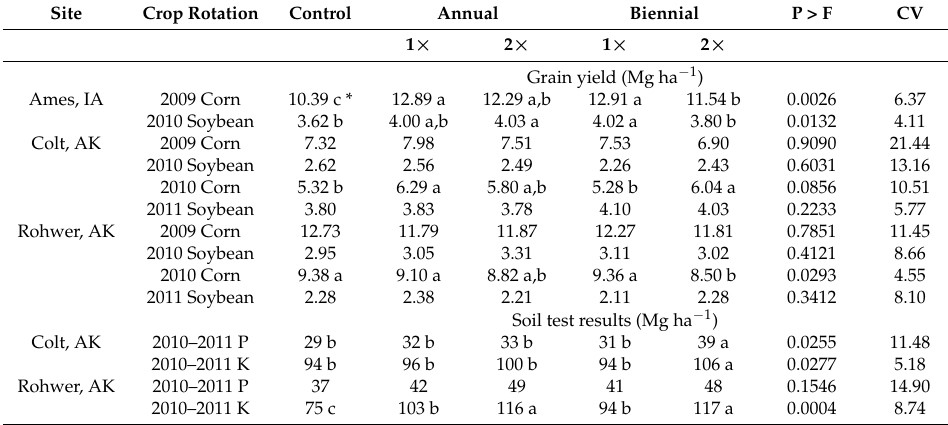
Table 3. Corn and soybean seed yield and soil test results affected by fertilizer treatments at sites with sub-optimal P and sub-optimal K.